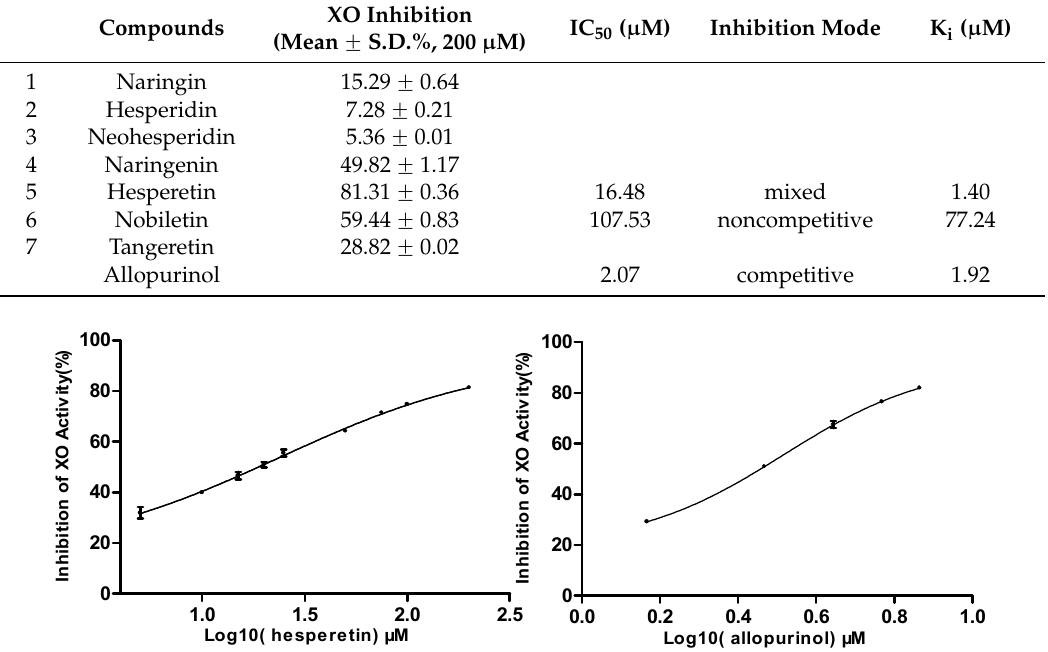
Table 2. Xanthine oxidase inhibitory activities of the isolated compounds.